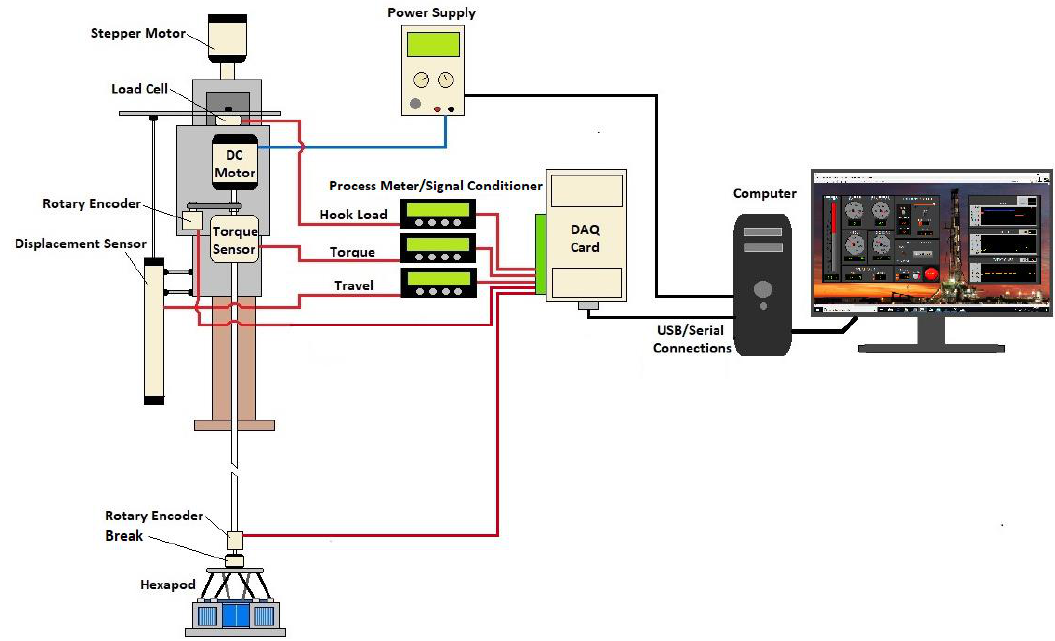
Figure 1. Main components of the setup.